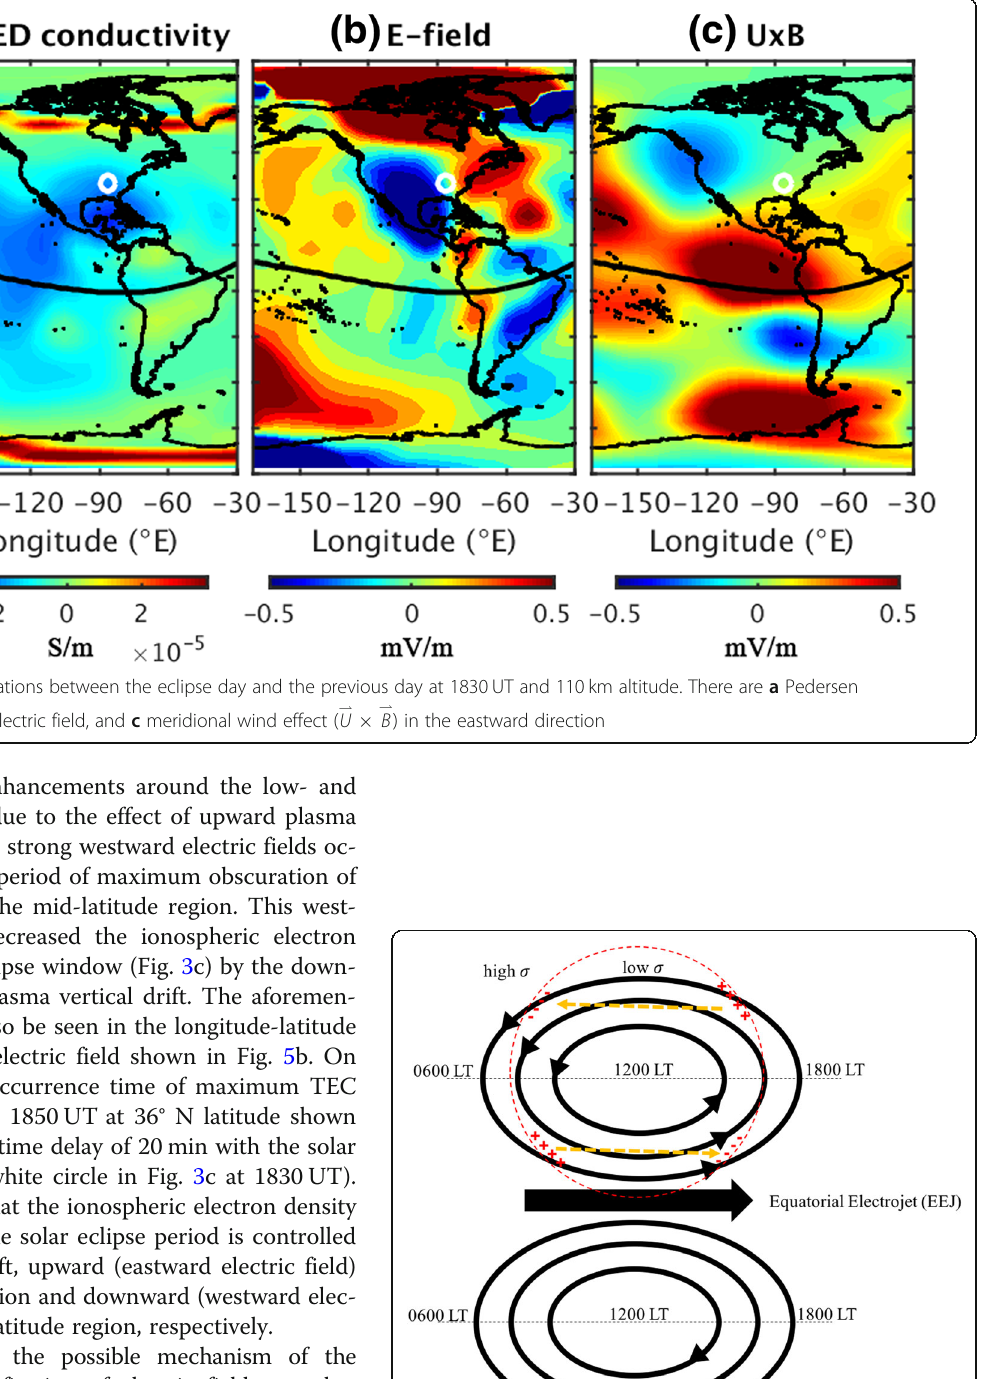
Fig. 6 Eclipse-induced enhancement on the eastward and westward electric fields at the low- and mid-latitudes, respectively. The red- dotted line indicates the effect range of the solar eclipse. The markers of “ + ” and “ − ” in the red color indicate positively and negatively charged particles, respectively. The orange-dotted line indicates the induced electric field